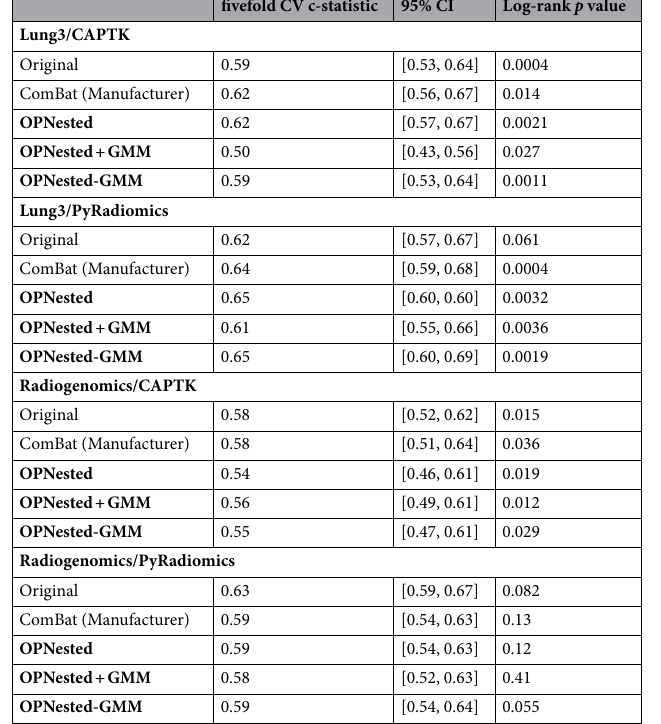
Table 3. C-statistics and 95% confidence intervals (CI) (over 2000 iterations) for fivefold cross-validated Cox proportional hazard models built exclusively from imaging-based features decomposed with PCA (with no added clinical covariates) to predict survival, and log-rank p values for Kaplan–Meier curve separation. ComBat (Manufacturer) indicates data was harmonized by manufacturer with